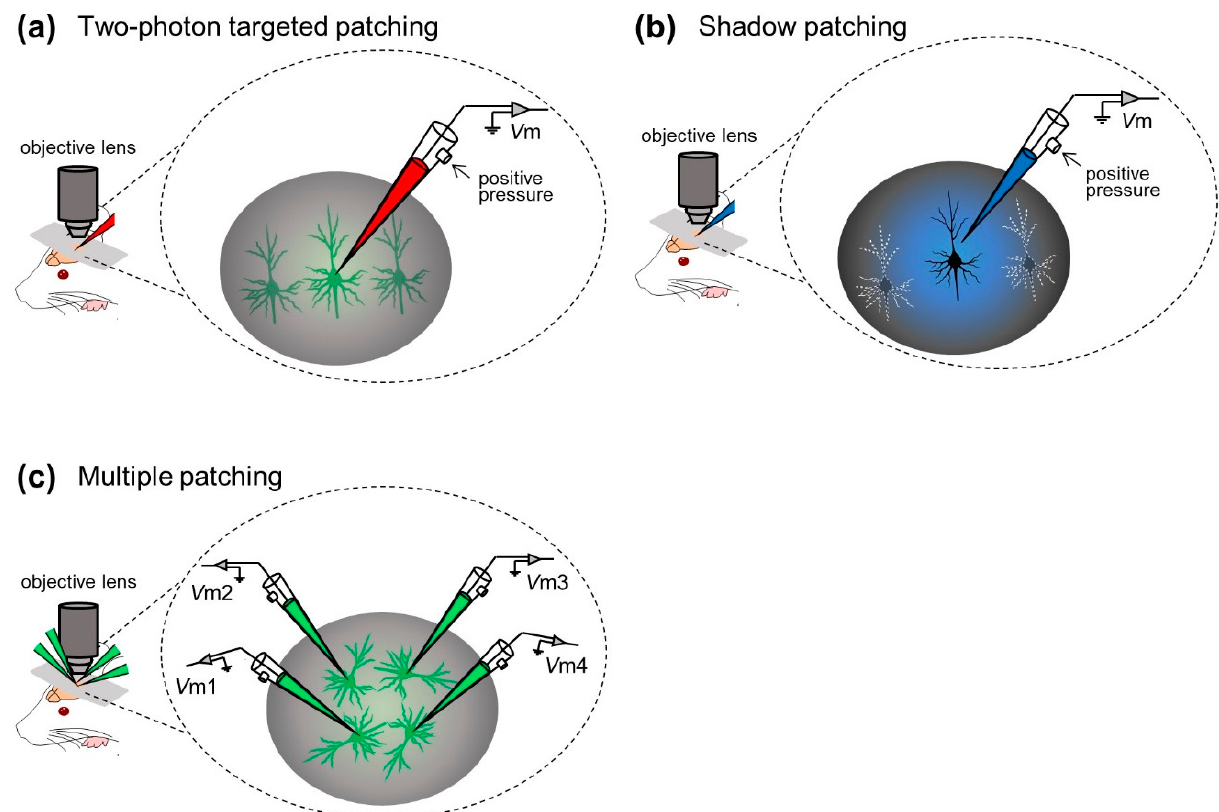
Figure 3. Examples of visually guided in vivo whole-cell recording techniques. ( a ) Whole-cell recordings are made from neocortical neurons with the aid of two-photon microscopy. ( b ) Whole-cell recordings are made from neocortical neurons under visual monitoring of the shadow of neuronal morphology. ( c ) Whole-cell recordings are made simultaneously from up to four neurons. Abbreviation : V m, membrane potential.